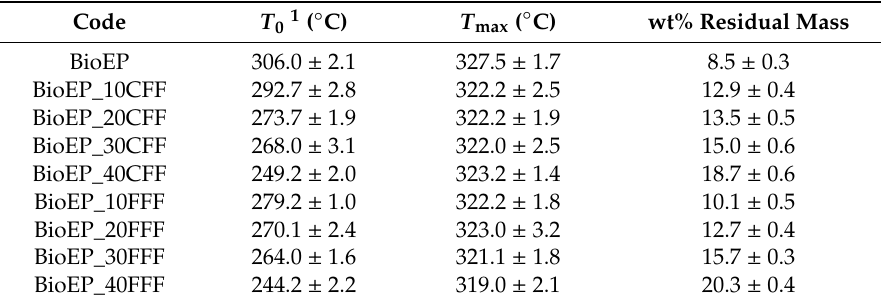
Table 2. Thermal parameters of BioEP and BioEP / FF composites reinforced with di ff erent contents of coarse (CFF) and fine (FFF) flaxseed flour, obtained by thermogravimetry